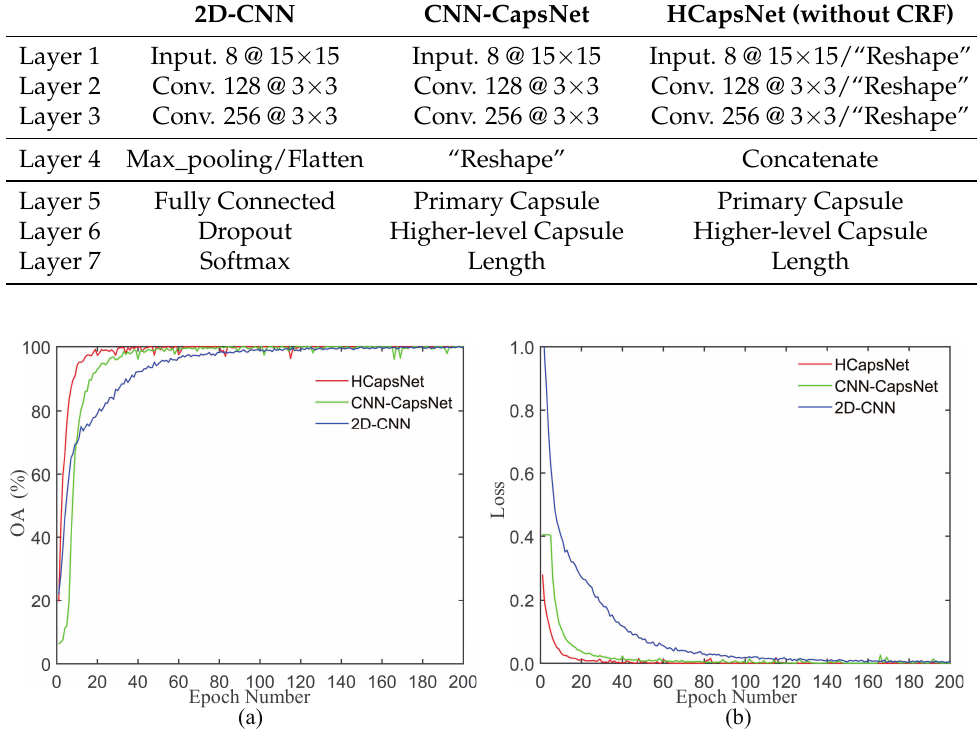
Figure 18. The loss and accuracy curves of different methods variation with iteration increasing.